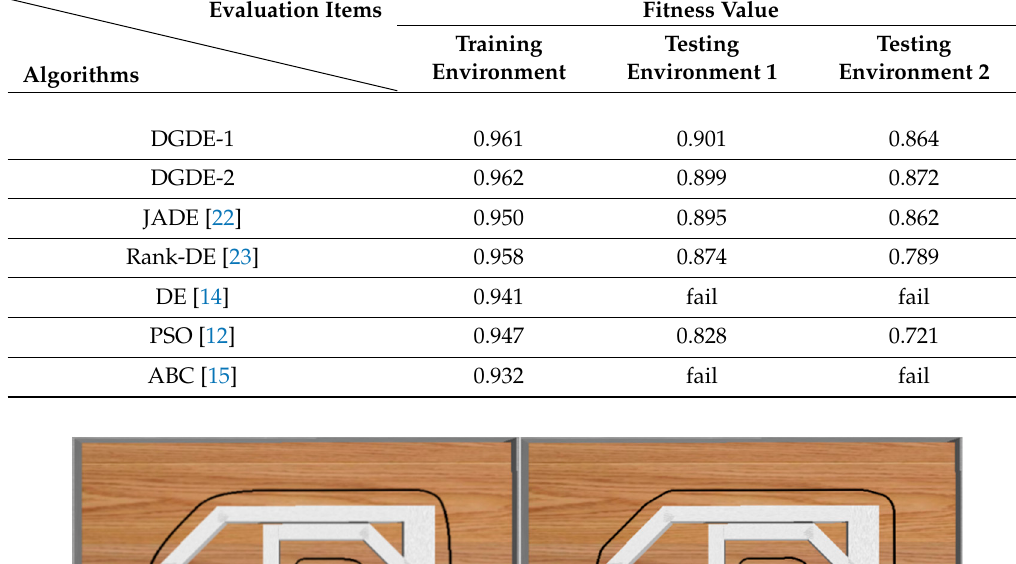
Table 5. Fitness value of various algorithms in the testing environments.